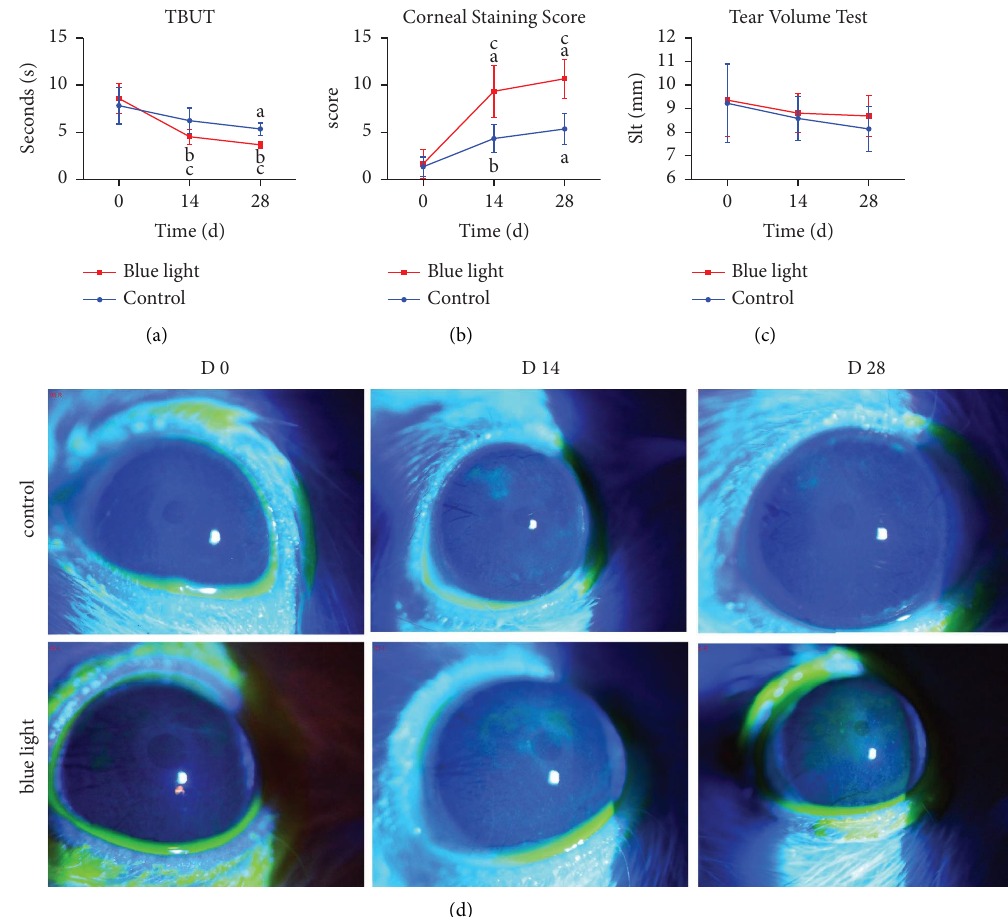
Figure 1: Examination of clinical dry eye parameters in normal and blue light-treated rat corneas. (a, b) Increased fuorescein staining and decreased TBUT were recorded in both groups. Compared with the control group, the blue light group showed signifcantly shorter TBUT and higher fuorescein sodium staining scores after blue light treatment. a P < 0 . 01 compared with day 0; b P < 0 . 001 compared with day 0; control vs. blue light: c P < 0 . 001. (c) Both groups showed no signifcant changes of tear secretion within and between groups. (d) Representative examples of fuorescein sodium staining on day 28 (right line, d) compared to day 14 (middle line, d) and day 0 (left line,